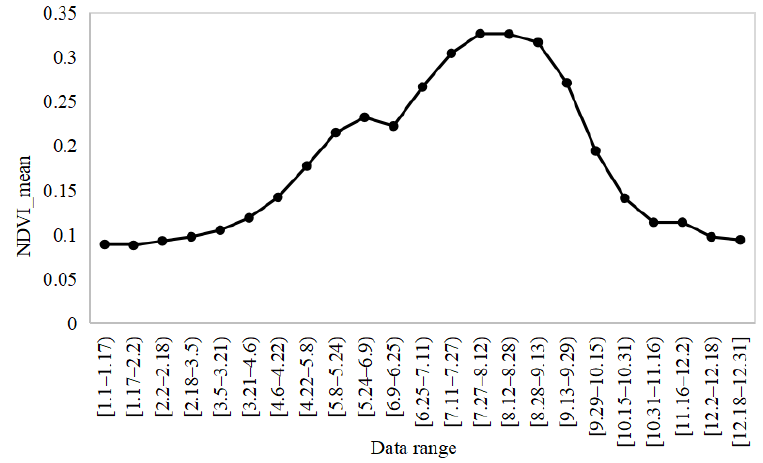
Figure 9. Temporal change of mean NDVI in Beijing – Tianjin – Hebei.